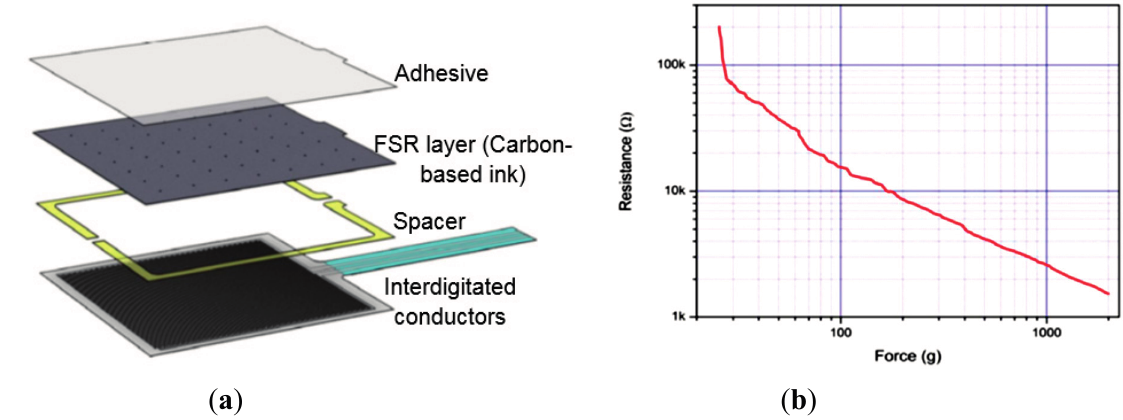
Figure 2. ( a ) Basic architecture of the FSR406 pressure sensor used in the sensing system; ( b ) a typical Force vs. Resistance curve for the FSR series sensors. Figures reused from the manufacturer’s datasheet [31] with permission from Interlink Electronics ® .